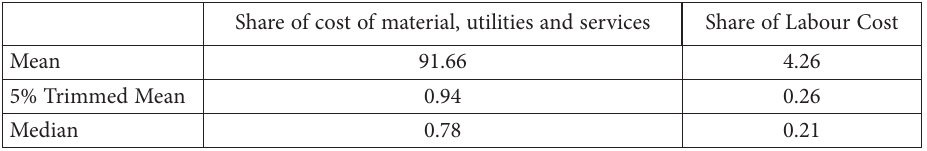
Table 3. Shares of cost on the companies’ sales (source: author based on Bisnode MagnusWeb) Share of cost of material, utilities and services